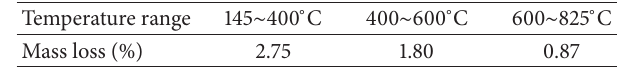
Table 5: Mass loss measured from